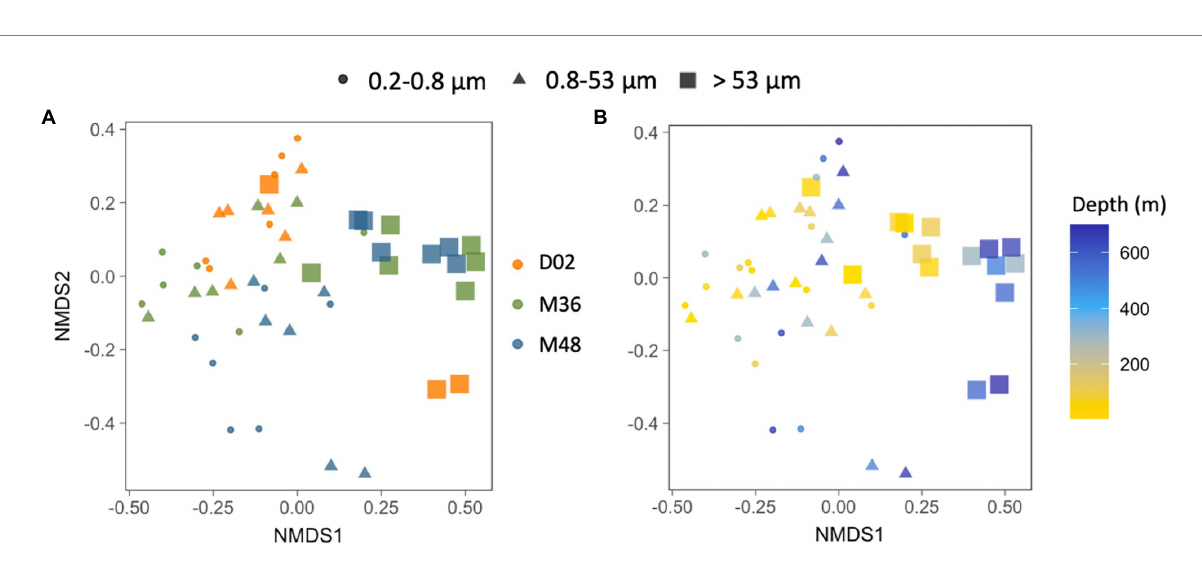
FIGURE 5 (A,B) Non-multidimensional scaling analysis (NMDS) based on the Bray–Curtis dissimilarity between all the studied prokaryotic communities, color-coded by sampling station (A) or by sampling depth (B) and indicating the different size-fractions. Stress value =